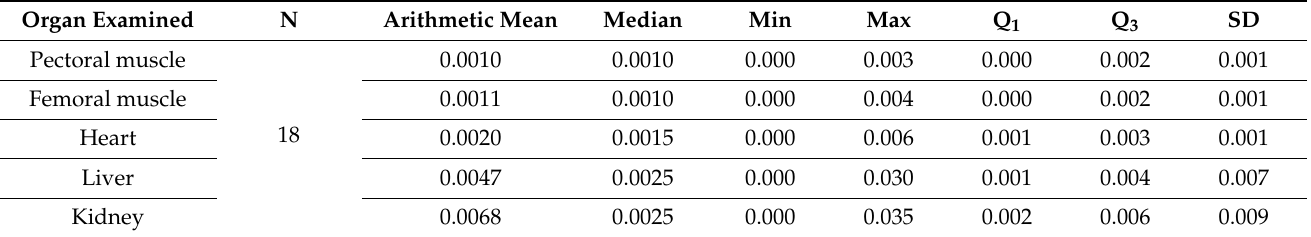
Table 1. Mercury concentrations in organs of common woodpigeons in milligrams per kilogram of wet weight.